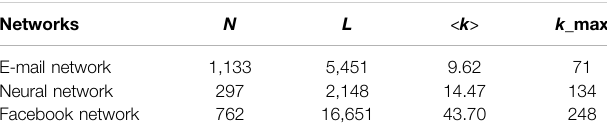
Frontiers in Physics |